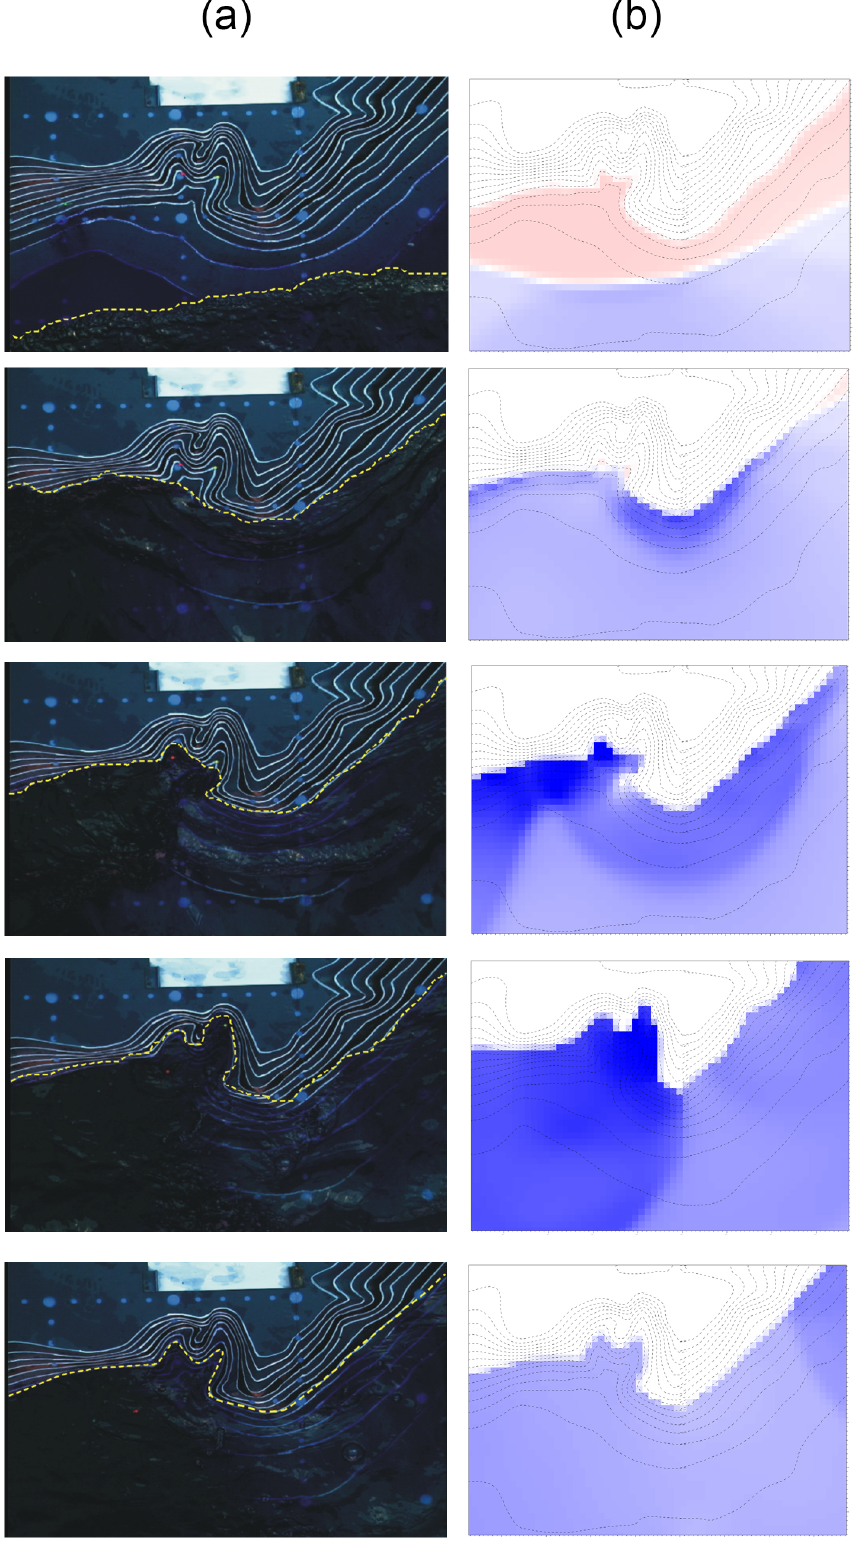
Figure A13. Comparison between extracted movie frames (a) and TRITON-G simulation (b) for times 15, 15.5, 16, 16.5 and 17s.